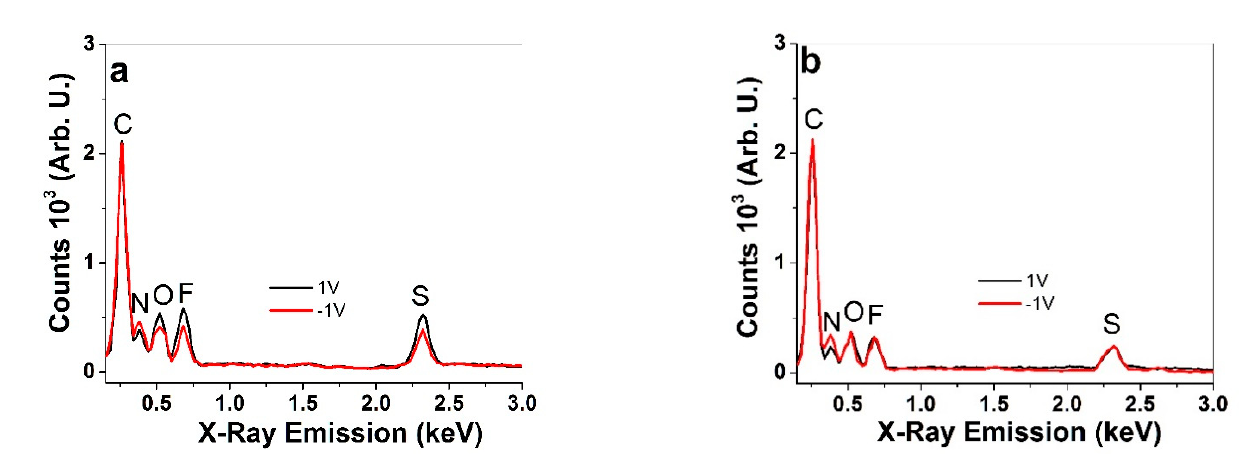
Figure 5. EDX spectra of the cross-sections of PPy films in oxidized state (1 V, 5 min polarization, black line) and at reduced ( − 1 V, 5 min polarization, red line) ( a ) PPy(pot) and ( b ) PPy(galv).